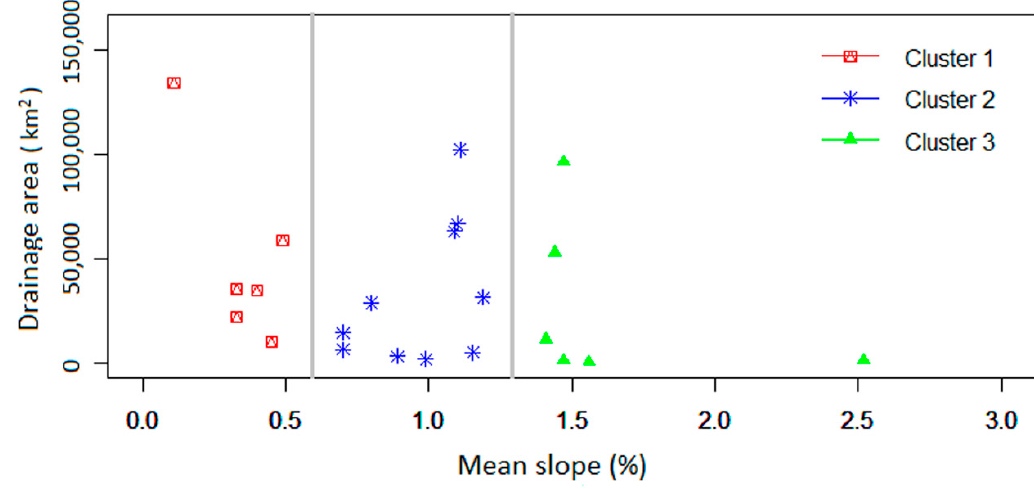
Figure 2. Discordancy measure (Di) of the different gauge sites.